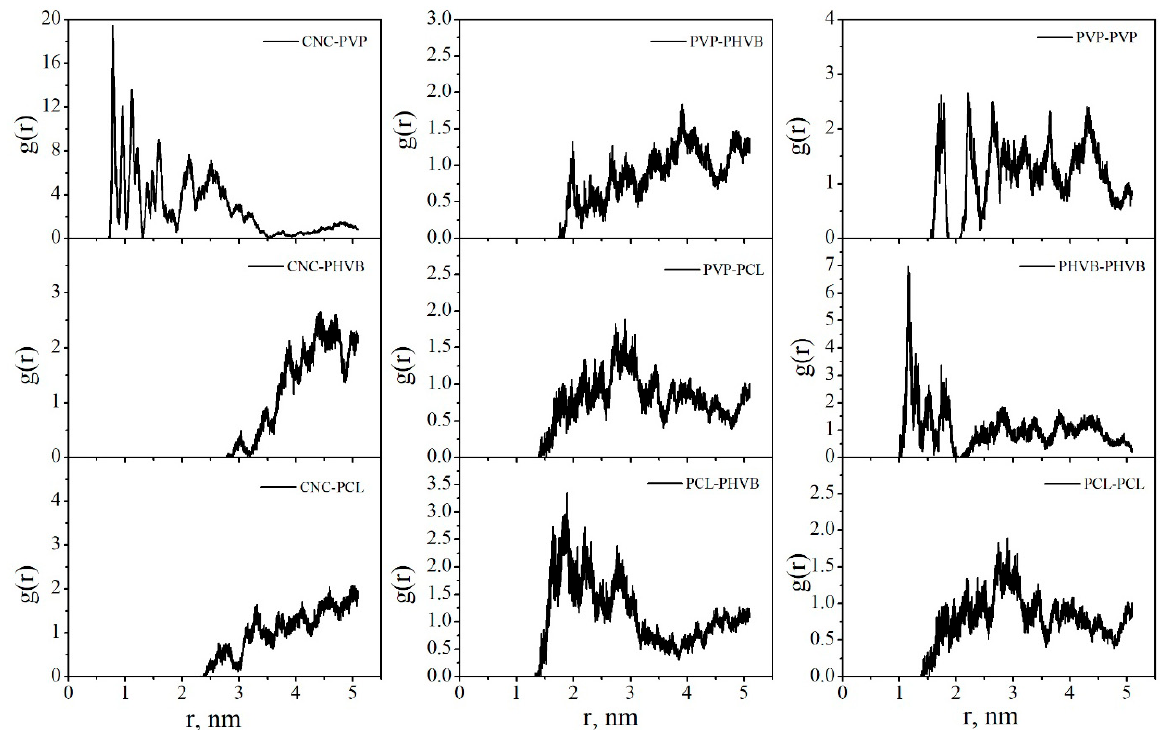
Figure 29. The radial distribution functions between the centers of mass of the composite components in DCM.